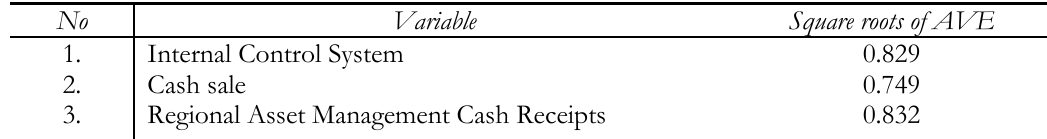
Test Results. Results of Square roots of AVE